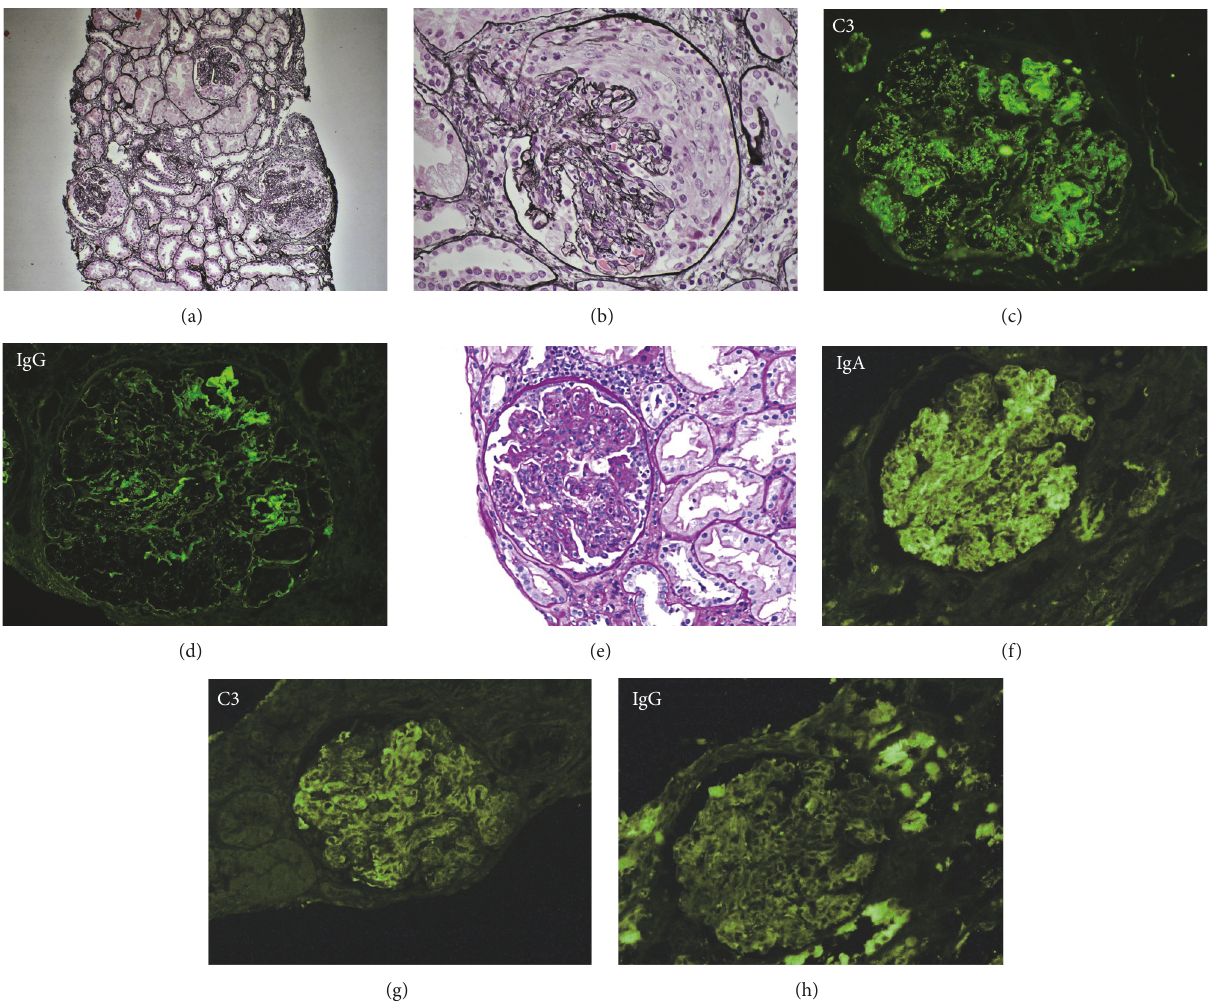
Figure 1: Case 1 (a-d): (a), (b) diffuse alteration of the glomerular structure with marked endocapillary inflammatory hypercellularity, double contours, and crescent formation. Silver stain. (c) Immunofluorescence C3 (+++) with granular pattern and mesangial and capillary distribution. (d) Immunofluorescence IgG (+++) with granular pattern and mesangial and capillary distribution. Case 2 (e-h): (e) glomerulus with marked endocapillary inflammatory hypercellularity. PAS stain. (f) Immunofluorescence IgA (+++) with granular pattern. (g) Immunofluorescence C3 (++) with granular pattern and mesangial and capillary distribution. (h) Immunofluorescence IgG